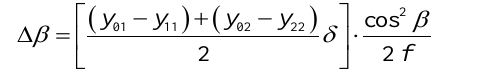
M 、 N — Spot imaging area-arrays 1 、 2 — Rated imaging positions 3 、 4 — Actual imaging positions L — The distance between the two area-array centers Figure 9. Changes in spot positions When the value of x is very small, the value of tan(x) or arctan(x) can be approximated as x. Then, the formula (4) can be simplified as follows: